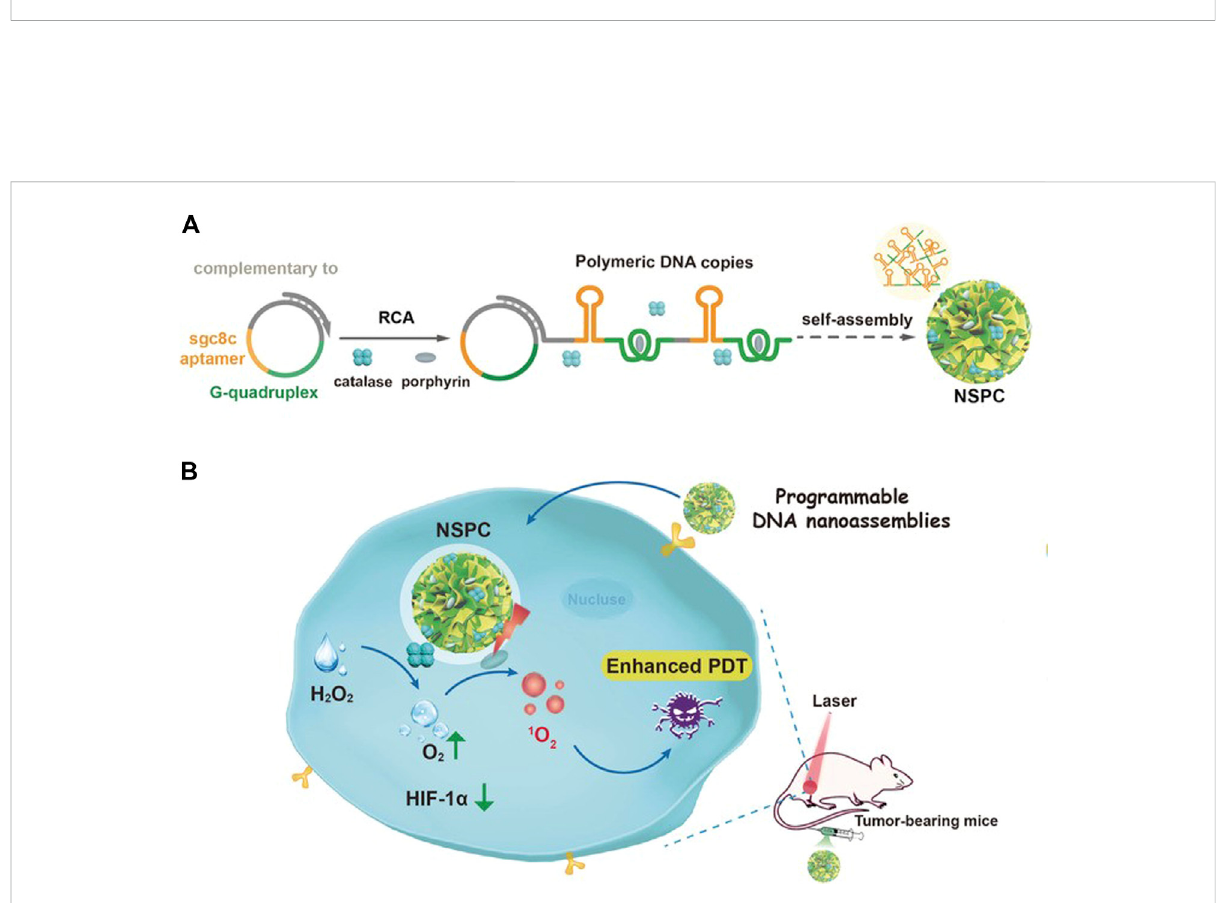
FIGURE 12 Illustration of designed DNA nanoassemblies for safe and effective PDT. (A) Design and synthesis of DNA nanosponges. (B) Proposed strategy for enhanced PDT with programmable nanoassemblies. Reproduced with permission from Ref. (Pan et al., 2020).